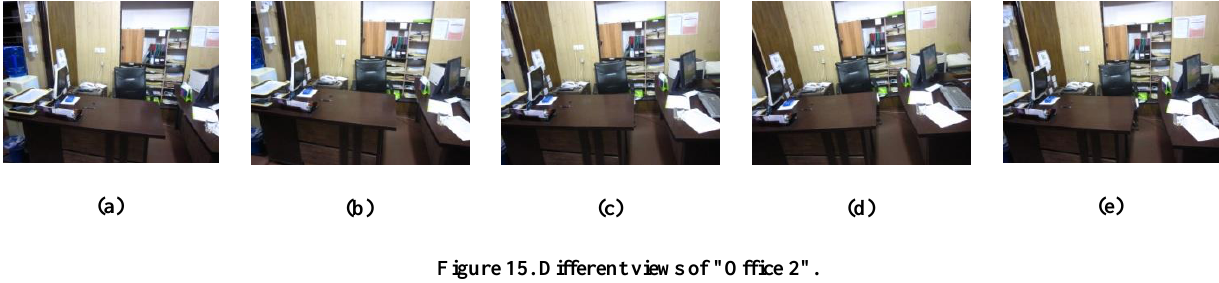
T =5.8 , T =2.8 , T =1.5 , and (c) the real image. 1 2 3